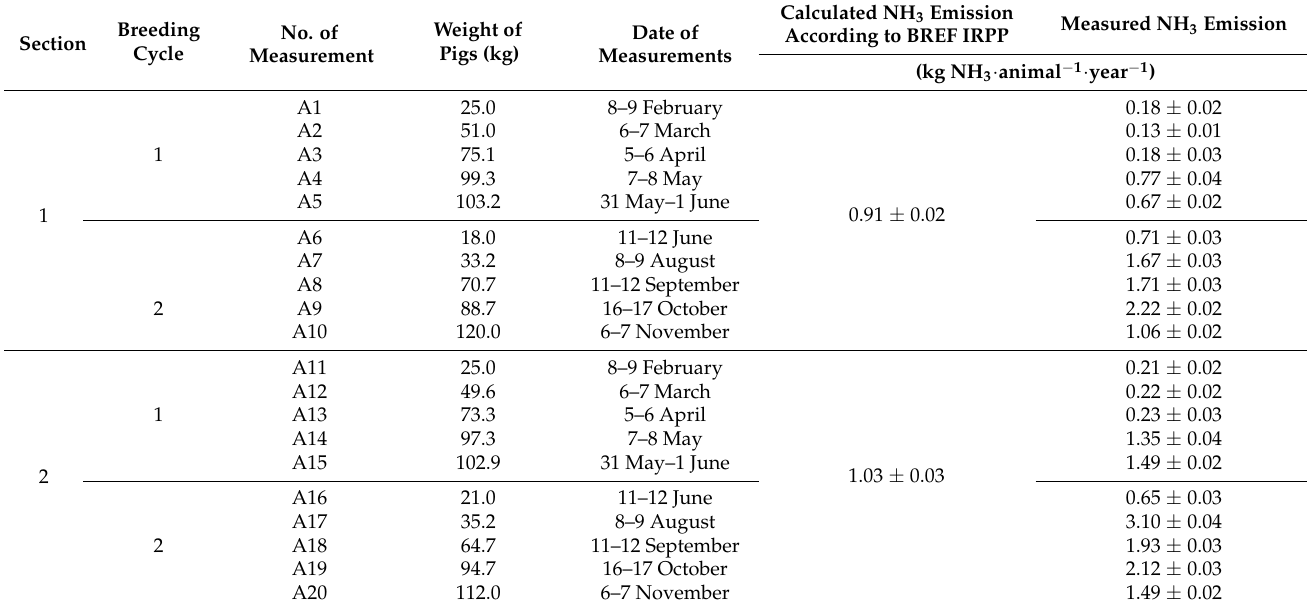
Table 6. Results of the calculation of NH 3 emission from the second approach